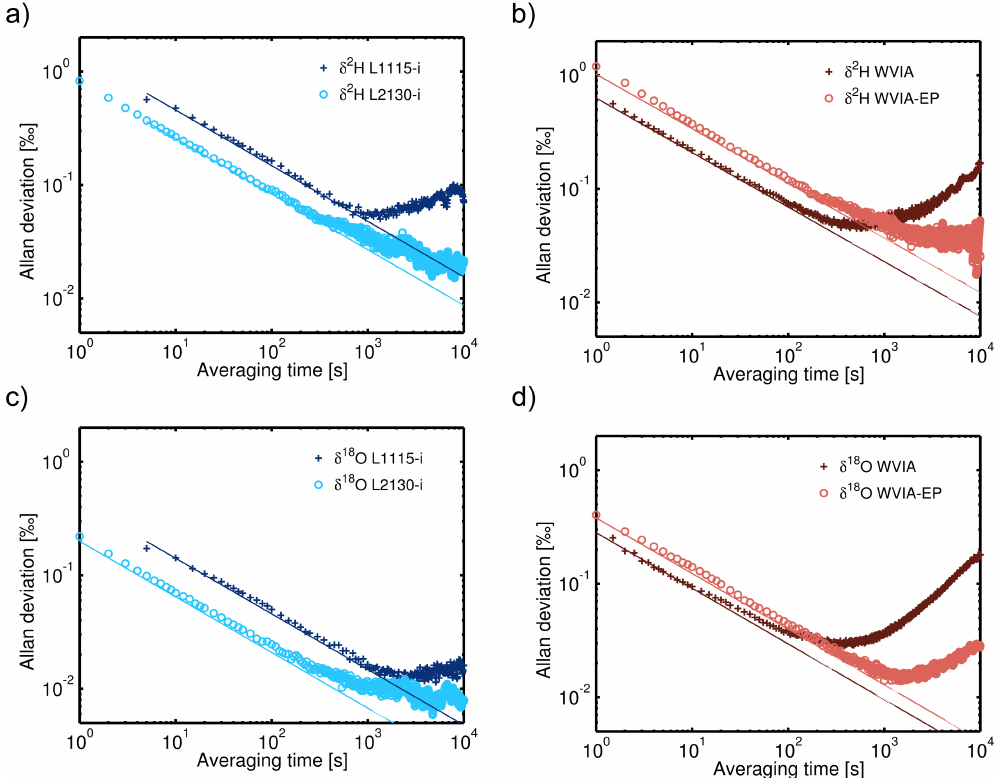
Fig. 7. Short-term stability of δ 2 H ( a and b ) and δ 18 O measurements ( c and d ) at 15700ppmv water vapour mixing ratio by L1115-i/L2130-i ( a and c ) and WVIA/WVIA-EP ( b and d ). The square root of the Allan variance is shown as a function of aggregation time on a log-log scale. The solid lines show the expected behaviour of a pure white noise signal with the same variance as the measured signal at the time scale of data acquisition (5s for L1115-i and 1s for WVIA, WVIA-EP,